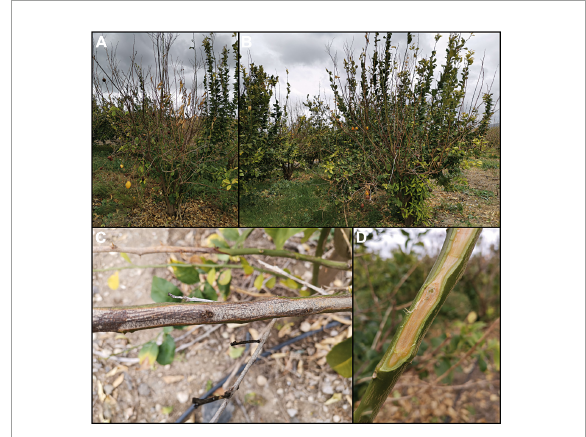
FIGURE1 Symptoms and signs of mal secco disease (MSD) in a commercial lemon orchard (Mineo, Catania province, Italy). (A,B) Wilting and defoliation in young lemon trees. (C) Withered twig of lemon with pycnidia of Plenodomus tracheiphilus (pycnidia appear as scattered black spots). (D) Longitudinal section on a lemon twig with the typical orange-reddish discoloration of the